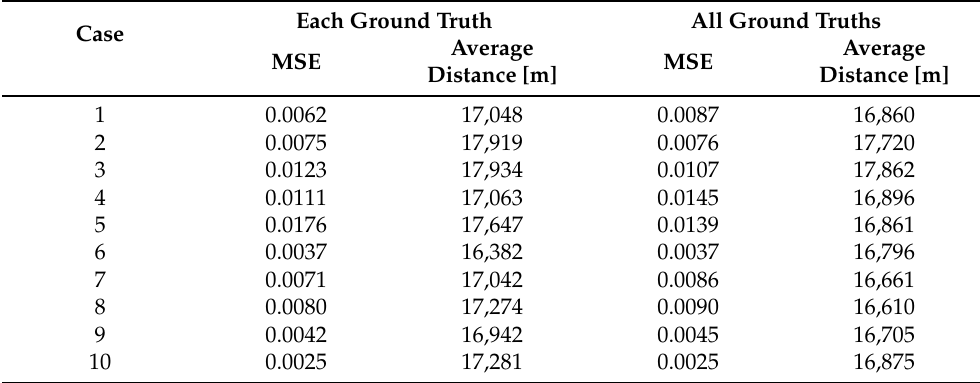
Table A2. Comparison of the MSE and the average distance using the values of Table A1.